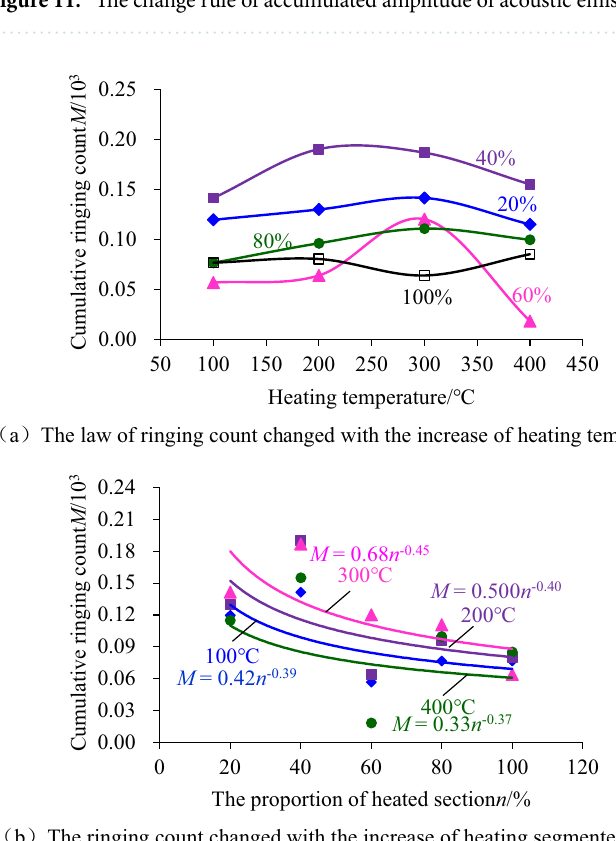
Figure 12. The change rule of cumulative ringing count with the increase of the heating segment